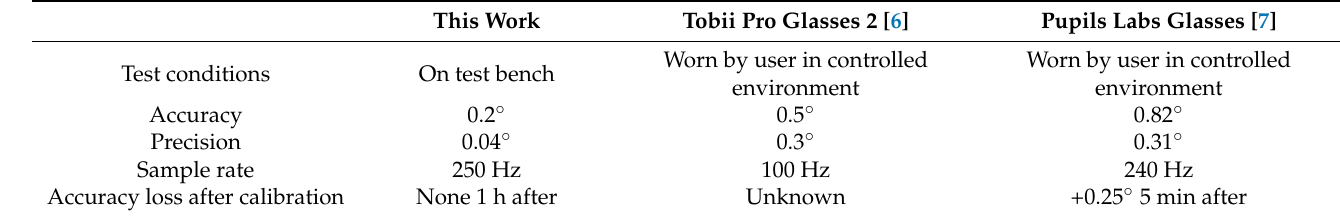
Table 2. Eye-tracker main features and performances.